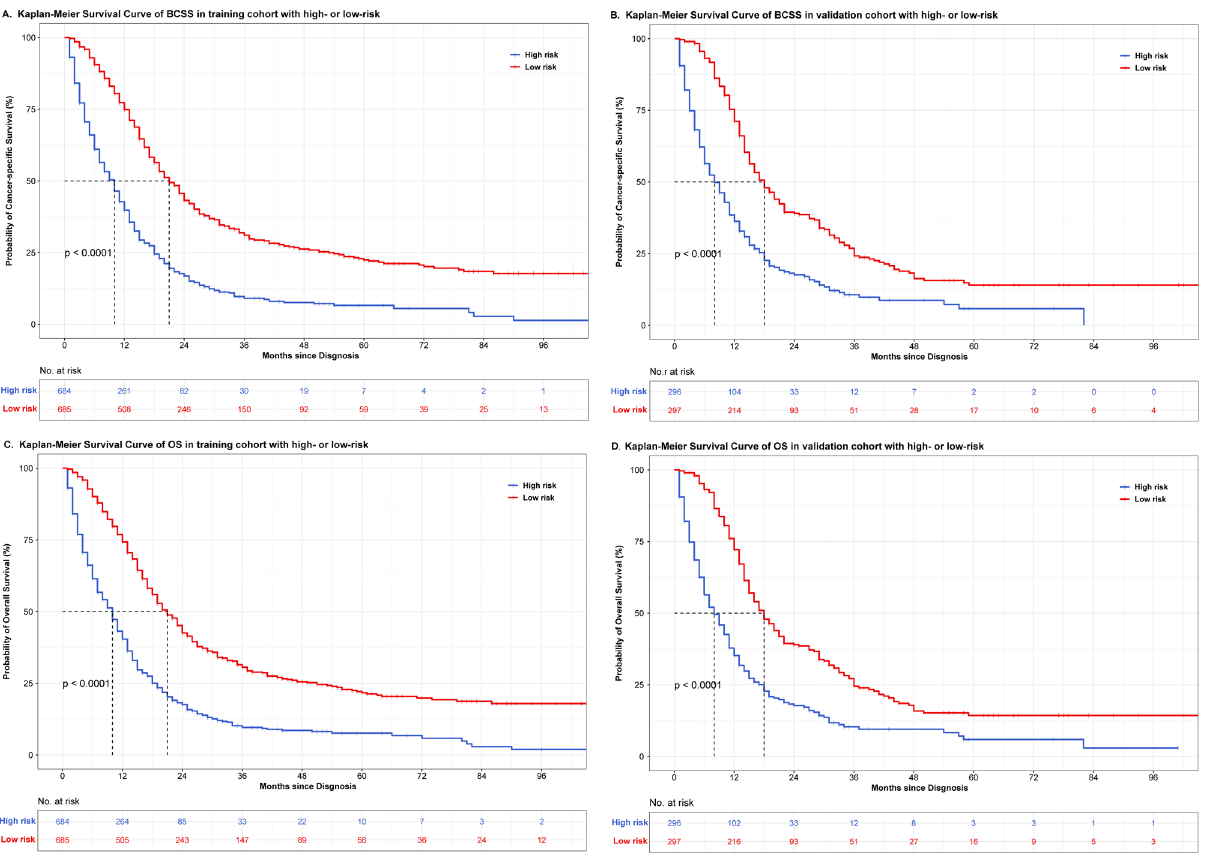
Figure 6. Survival curves of BCSS and OS stratified by nomogram estimated risk. ( A , B ) BCSS in training and validation cohort, respectively. ( C , D ) OS in training and validation cohort,